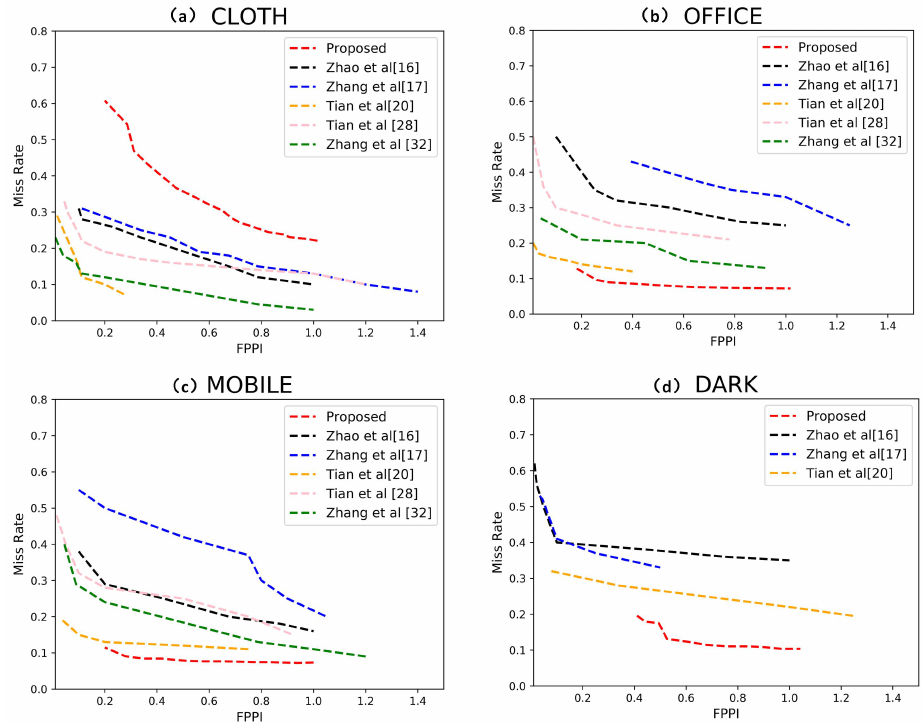
Figure 6. Comparisons of the performance of AAFTS-net and other state-of-the-art methods on four datasets: ( a ) CLOTH, ( b ) OFFICE, ( c ) MOBILE, and ( d )